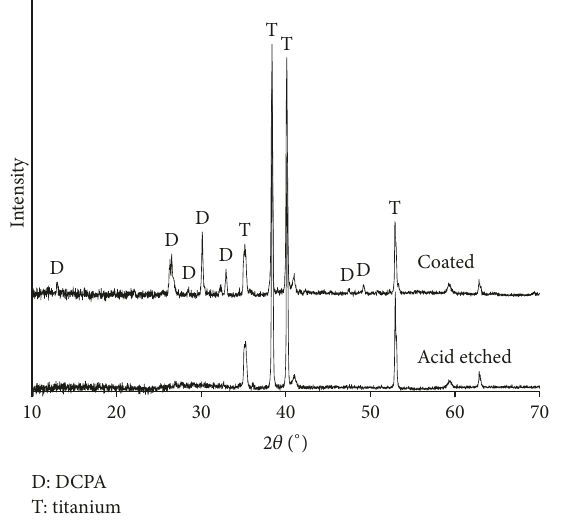
Figure6:XRDpatternsofspecimensafter100timesofspray-drying